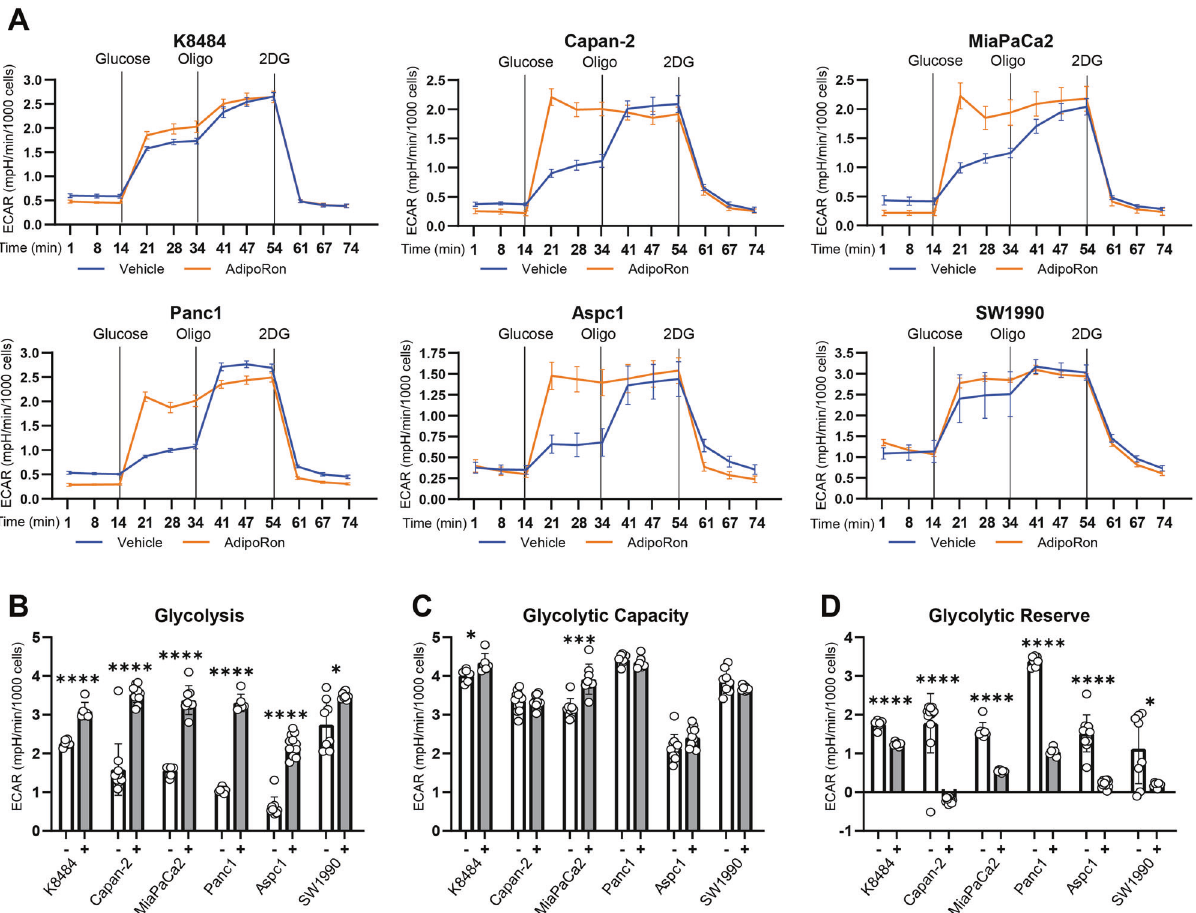
Fig. 3 AdipoRon activates glycolysis in pancreatic cancer cell lines. Seahorse XFe96 bioanalyzer was used to measure extracellular acidi fi cation rate (ECAR) in six different PDAC lines ( A ) either untreated (vehicle) or pretreated with 25 μ M AdipoRon for 45 min, with initial basal measurements followed by sequential injections of glucose (10 mM), oligomycin (2 µM), and 2-deoxy-d-glucose (2-DG) (50 mM). Glycolysis ( B ), glycolytic capacity ( C ), and glycolytic reserve ( D ) were calculated from the ECAR measurements in ( A ) for the respective cell lines. Statistics: t -test, n ≥ 3; error bars, SD; * P <